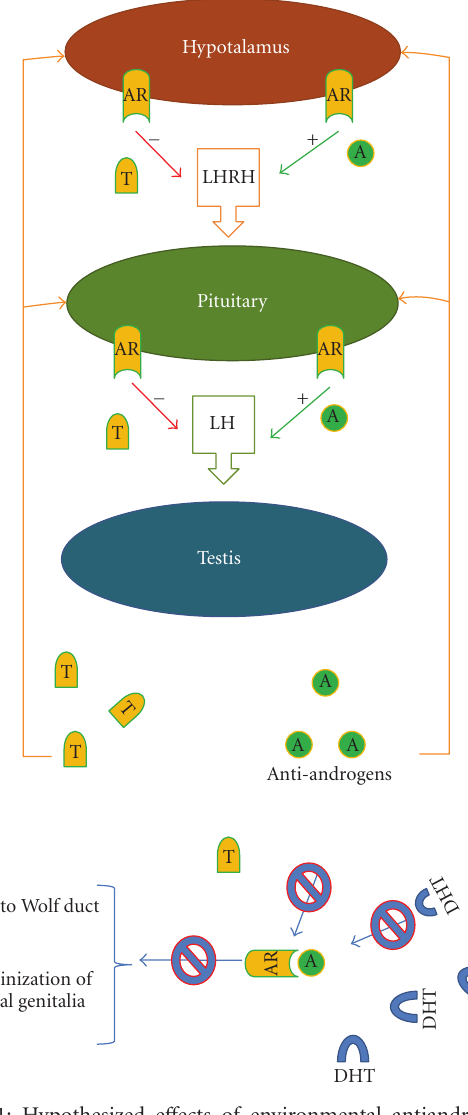
Figure 1: Hypothesized e ff ects of environmental antiandrogens on the hypothalamic-pituitary-testis axis. (A) In normal condition androgens as testosterone (T) and dihydrotestosterone (DHT) exert negative influence on secretion of LHRH and LH by the hypothalamus and the pituitary, respectively. (B) Antiandrogens compete with T and DHT for binding to the androgen receptor (AR). The impaired ability of testosterone (T) to bind AR weakens the inhibitory feedback of T on LHRH and LH production by preventing the hypothalamus and anterior pituitary from recog- nizing the presence of T. This results in hypersecretion of LH and increased production of T by Leydig cells. Blocking peripheral AR by antiandrogens inhibits androgen-mediated e ff ects on target organs potentially resulting in incomplete masculinization and malformations of the male reproductive